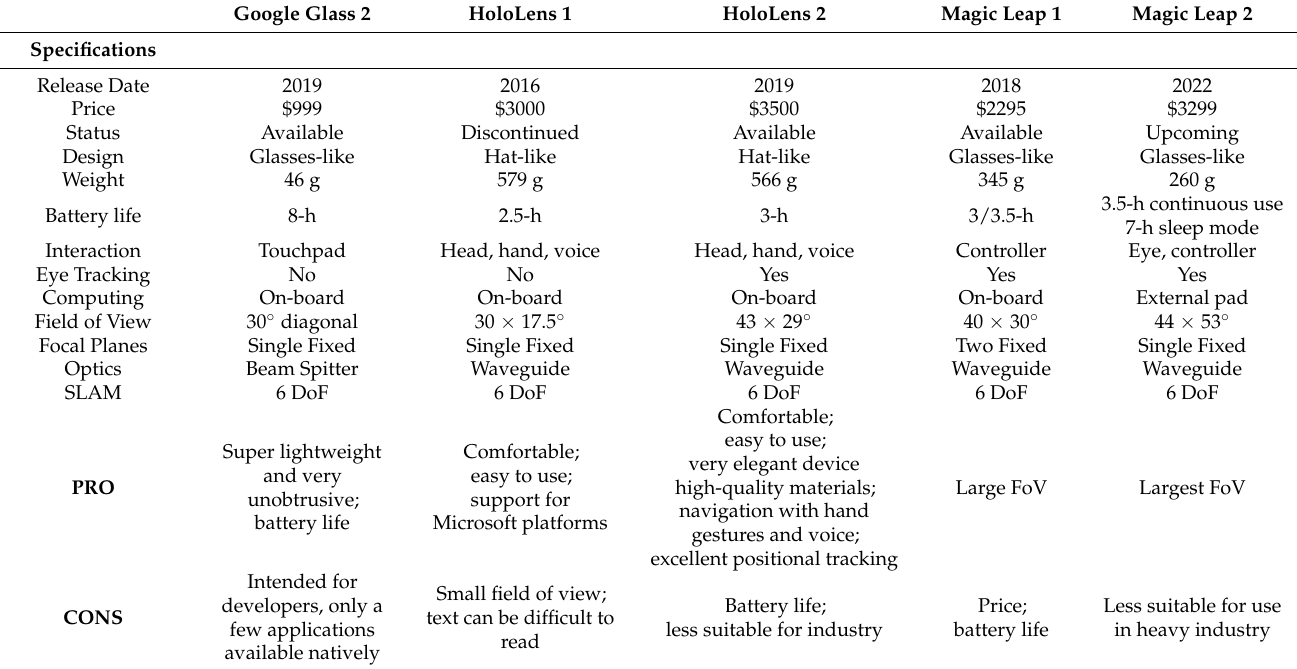
Table 2. Basic technical specifications for commercially available optical see-through head- mounted displays.